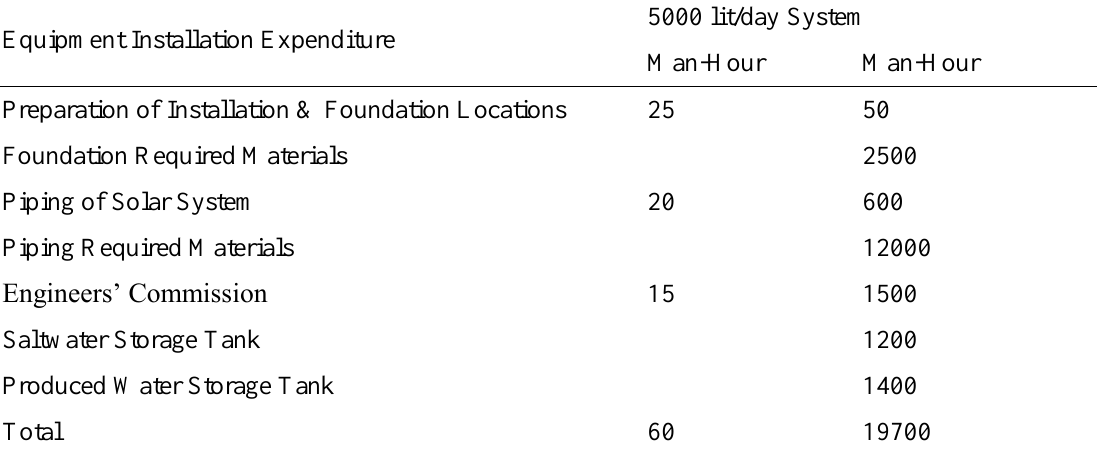
Table 6. Installation Expenditure of MEH Desalination Unit